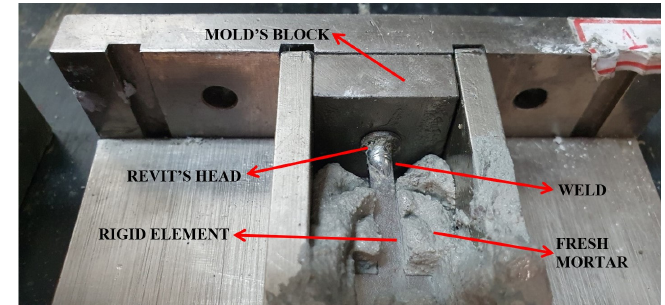
Figure 4. Rivet’s head bigger than the mold’s block hole